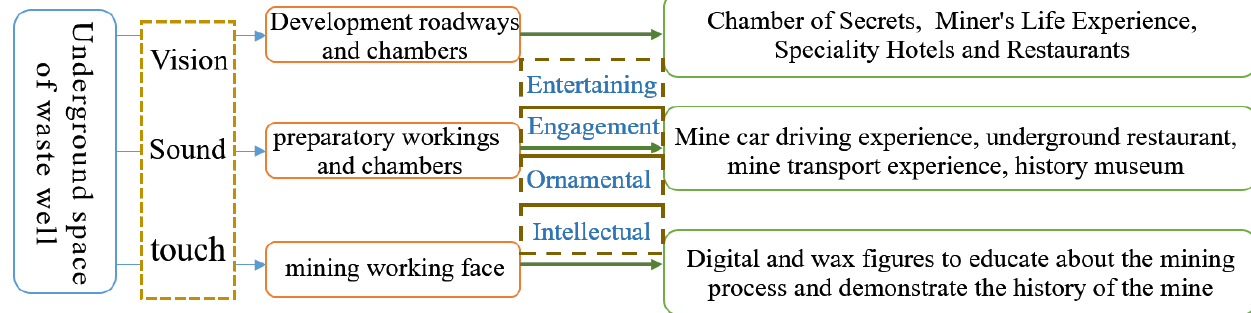
Figure 10. Abandoned underground mine tourism project development.